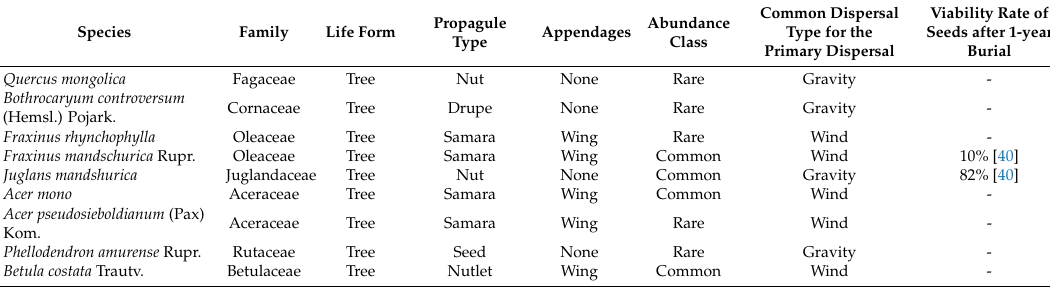
Phellodendron amurense Rupr.